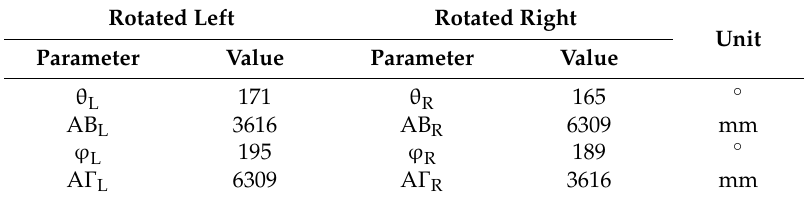
Figure 8. Relevant dimensions and schematic illustration for the modeling of the representative plow points for the two rotating positions of the plow: ( a ) rotated left; and ( b ) rotated right. For every rotating position separately, two points were defined that represented the lateral edges of the working width (points B and Γ ). As can be seen in Figure 8a,b, the representative plow points are formed by first drawing a line parallel to the outer edge of the first and last share and crossing it with a perpendicular line, which is touching the front top of the shares. Then, this intersection point is projected vertically to the height of the antenna (Point A) to get the representative plow point. For the subsequent calculations, the left and right plow vectors pointing from the antenna to the representative points of the plow were created. Then, the ϕ angle ( ϕ L and ϕ R for both rotating positions) and the θ angle ( θ θ L and R for both rotating positions) were determined. They represent the angle between the forward direction and the left and right plow vectors. Furthermore, the length of the left and right plow vectors for both rotating positions (AB L and AB R , and A Γ L and A Γ R , respectively) was determined. The values for these dimensions, which indicate the position of the representative plow points relative to the antenna position, are presented in Table 2. Table 2. Relevant dimensions for the modeling of the representative plow points. Rotated Left Rotated